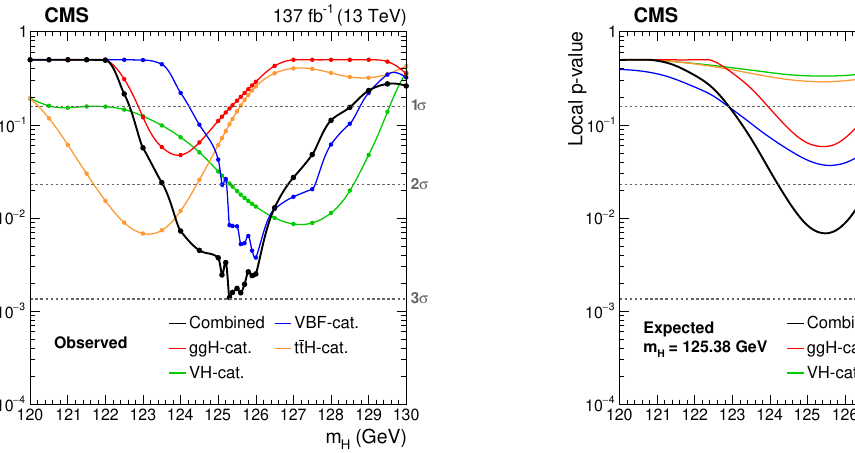
, extracted from the combined H